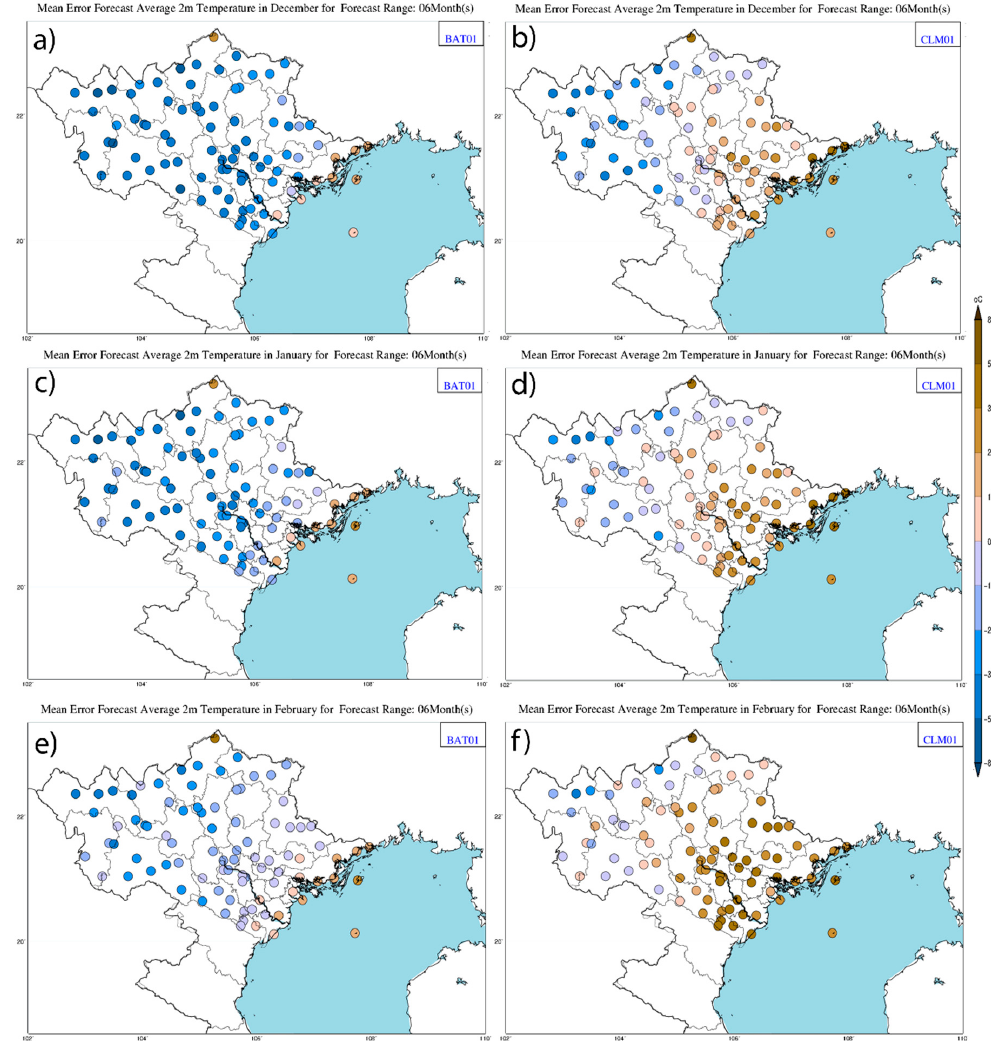
Figure 3. Mean errors (MEs) in the period 1998–2018 at stations over northern Vietnam for mean monthly temperatures in ( a , b ) December, ( c , d ) January, and ( e , f ) February; six-month forecast range of the BAT01 forecast ( a , c , e ) and the CLM01 forecast ( b , d , f ). The unit is ◦ C and the shaded color range is − 8 to 8 ◦ C with an interval of 2 ◦ C.